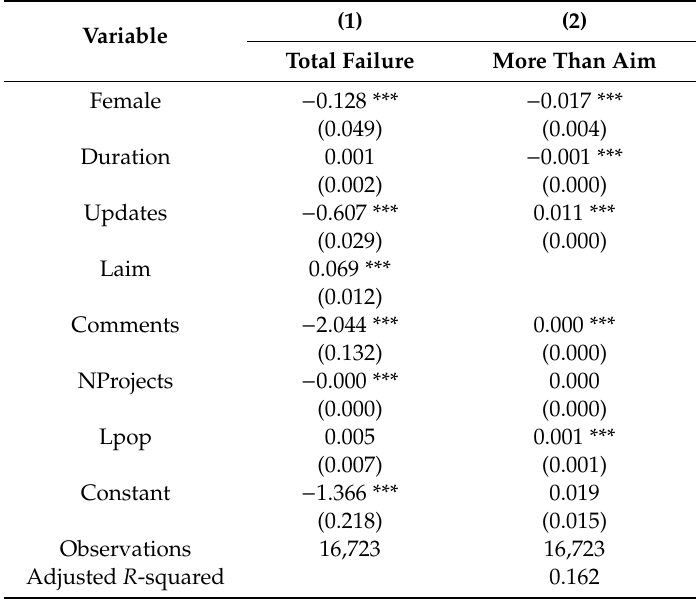
Table 16. Relationship between gender, total failure, and more than aim. Table 3 defines all the variables. (1) (2) Variable Total Failure More Than